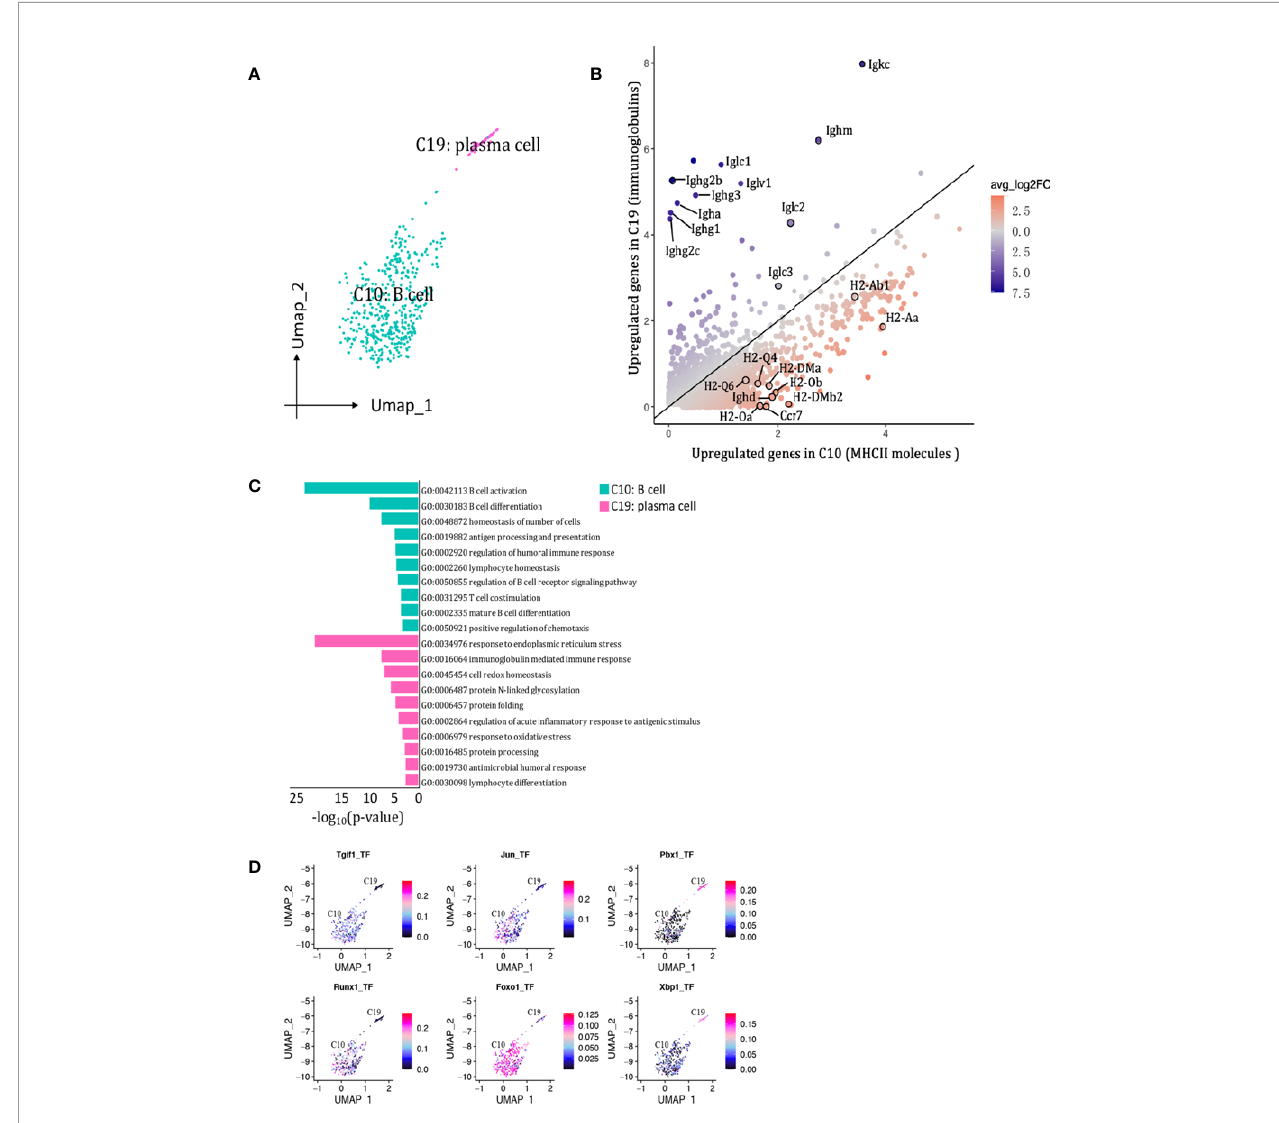
FIGURE 9 | B cells presented in the allografted kidneys. (A) Integrated UMAP projection of the 2 B cell clusters identi fi ed in the kidney grafts (clusters 10 and 19), colored according to cluster designation. Cell identities are annotated on the clusters. (B) Scatter plot showing average expression of genes in C5 versus C9. Each dot represents a gene, colored according to the average log 2 FC from white to blue or red. Genes encoding immunoglobulins and MHCII molecules with |avg_log 2 FC| ≥ 0.59 in clusters 10 and 19. (D) Feature plot showing AUC scores for the ≥ 0.59 were circle and labeled. (C) Pathway enrichment of genes with avg_log 2 FC expression of gene sets regulated by transcription factors, as estimated with SCENIC, in clusters 10 and 19. UMAP, Uniform Manifold Approximation and Projection; avg_log 2 FC, average log 2 fold change; adj_p value, adjusted p value; AUC, area under the curve; SCENIC, single-cell regulatory network inference and